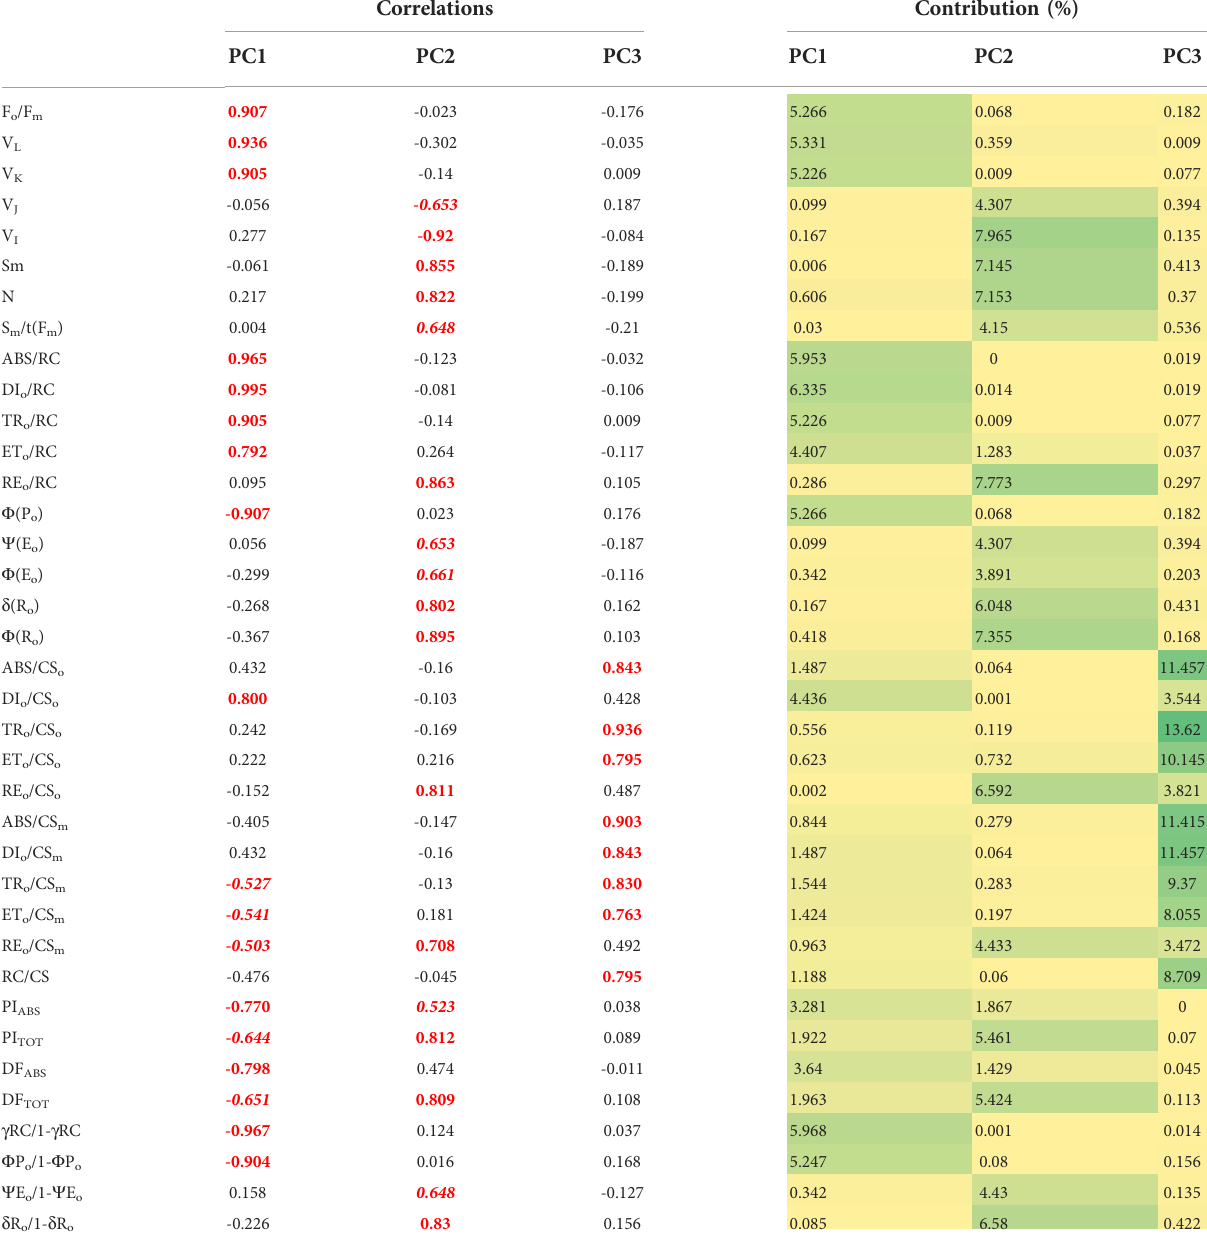
TABLE 3 Correlations between variables and factors and variable contribution (%) after oblimin rotation.